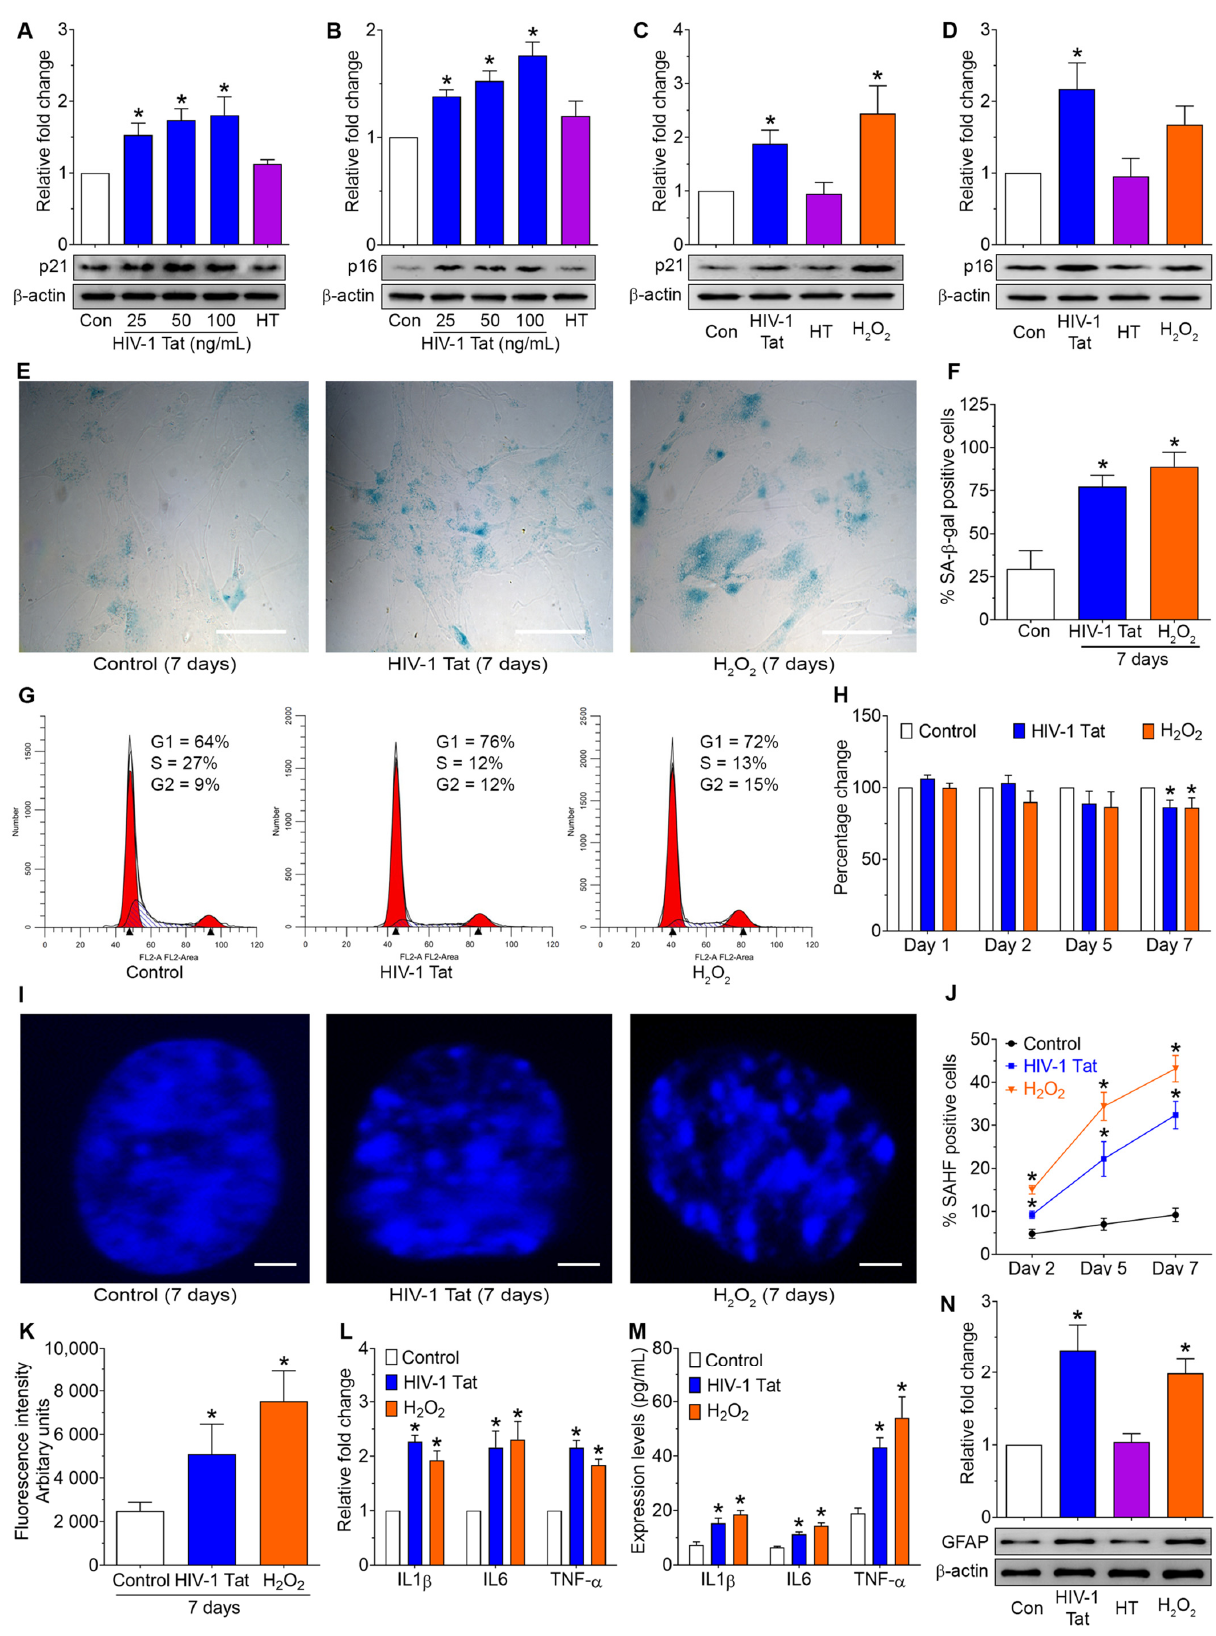
Figure 1. HIV-1 Tat increased the senescence-associated markers, ROS production, and proinflam- matory cytokines and cellular activation in human primary astrocytes (HPAs). ( A , B )